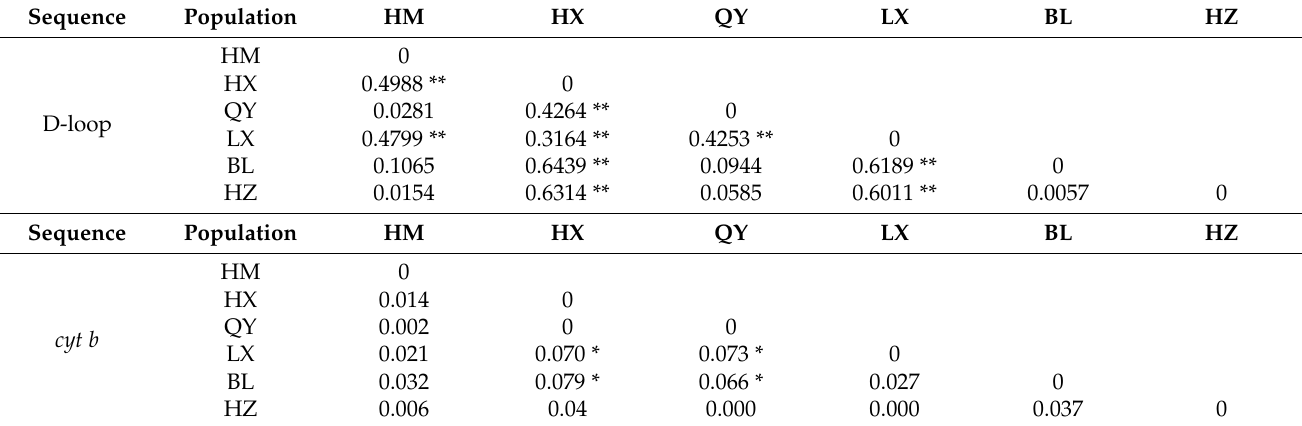
Table 4. Pairwise Φ ST (lower diagonal) between populations based on D-loop and cyt b sequences.